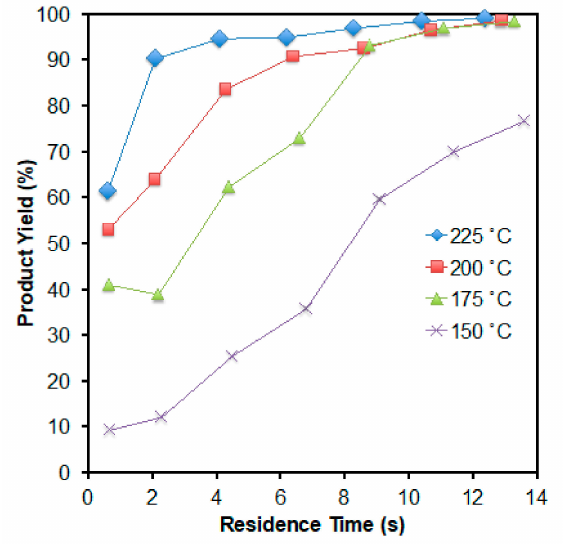
Figure 4. The residence time effect for the yield of 3 in SMC; (cid:7) : 225 ◦ C, (cid:4) : 200 ◦ C, (cid:78) : 175 ◦ C, × : 150 ◦